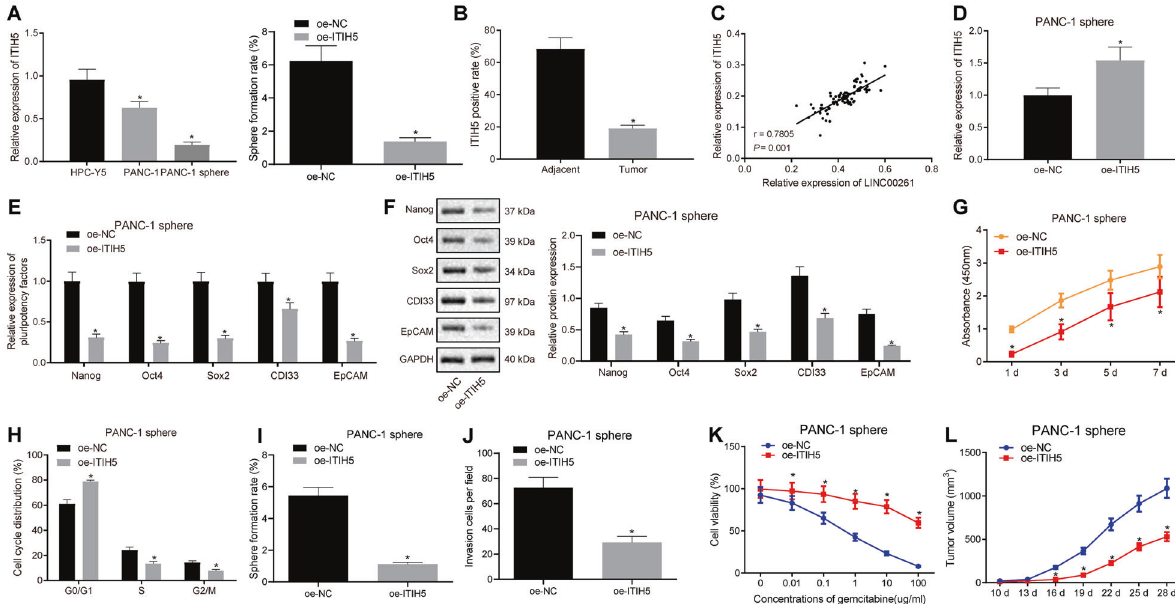
Fig. 5 Upregulation of ITIH5 suppresses the proliferation, self-renewal, invasion, and tumorigenicity of PC stem cells while enhancing their sensitivity to gemcitabine treatment. A ITIH5 expression in PANC-1 stem cells examined by RT-qPCR, * p < 0.05 vs. the HPC-Y5 cells. B ITIH5 expression in PC and adjacent normal tissues, * p < 0.05 vs. the adjacent normal tissues (200×). C Correlation analysis between LINC00261 and ITIH5. D The transfection ef fi ciency of oe-ITIH5 in PANC-1 stem cells determined by RT-qPCR. E The expression of stem cell markers in PANC-1 stem cells overexpressing ITIH5 determined by RT-qPCR. F The protein expression of stem cell markers in PANC-1 stem cells studied by western blot analysis. G Proliferation of PANC-1 stem cells overexpressing ITIH5 examined by CCK-8 assay. H Effect of ITIH5 overexpression on cell cycle distribution in PANC-1 stem cells examined by fl ow cytometry. I Cell sphere formation ability of PANC-1 stem cells. J Invasion of PANC-1 stem cells assessed by Transwell assay. K Cytotoxicity of PANC-1 cells. L Tumor volume in nude mice bearing PANC-1 stem cells overexpressing ITIH5, n = 5. * p < 0.05 vs. the oe-NC group (in D – L ). Each experiment was repeated three times and measurement data were expressed as mean ± standard deviation. Comparisons between two groups were analyzed by paired or independent sample t